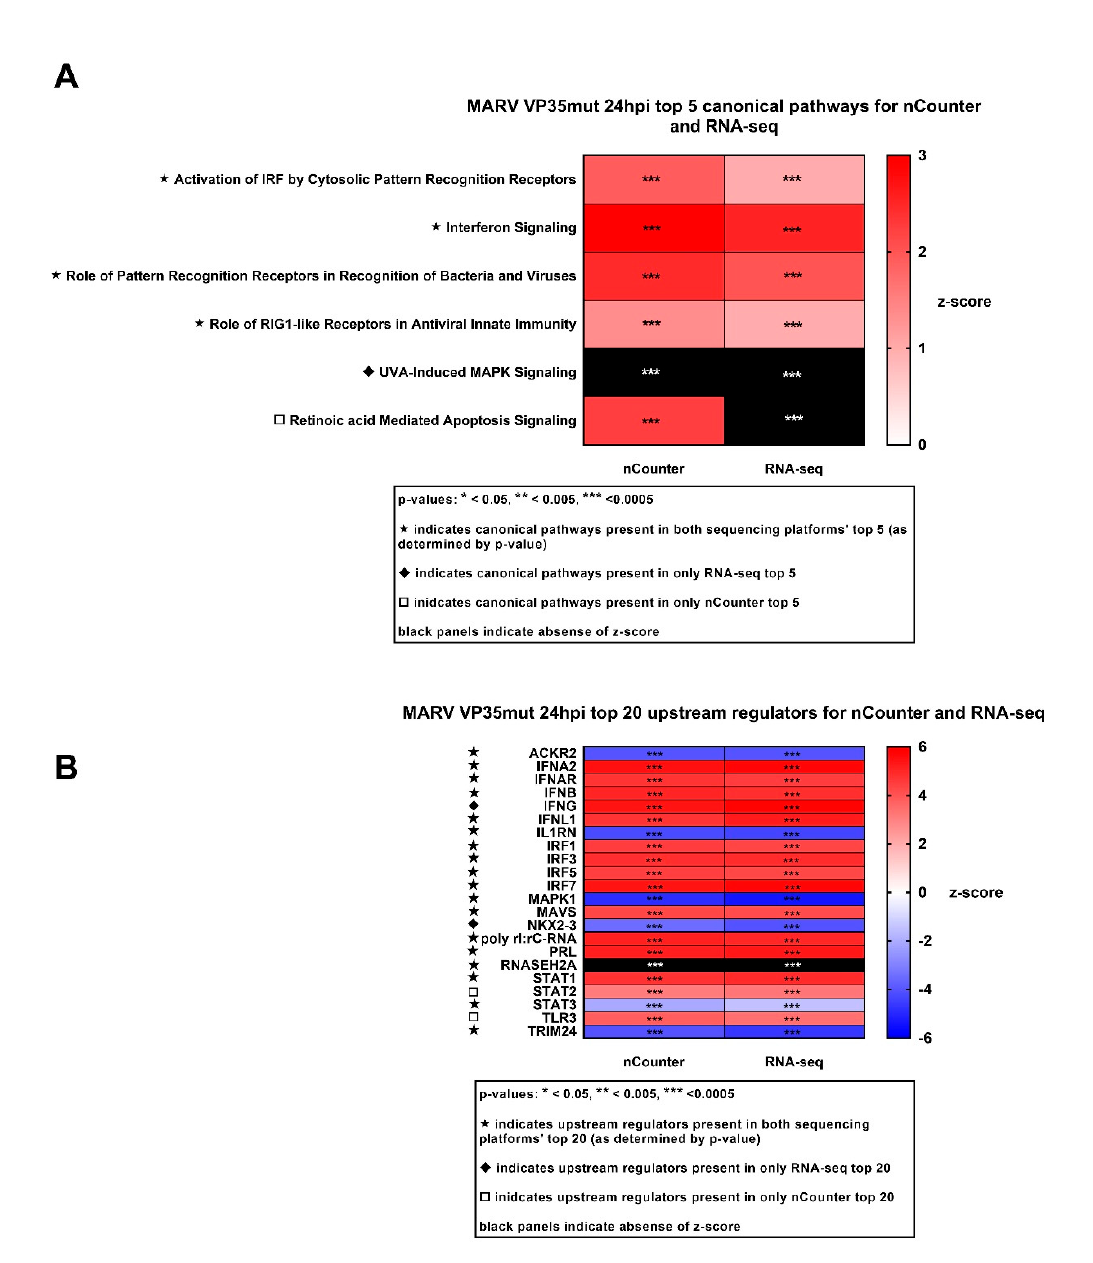
Figure 4. The top five canonical pathway and top 20 upstream regulators comparison between nCounter and RNA-seq for MARVmut. ( A ) The top 5 canonical pathways ranked by p -value. The key indicates which pathways are present in both platforms and which are present in only one. The z-score indicates an activation score calculated by IPA (Ingenuity Pathway Analysis) for each pathway. Positive values indicate that the genes in the dataset are behaving in a way that indicates positive regulation. Negative values indicate that the genes in the dataset are behaving in a way that indicates negative regulation. Black panels indicate canonical pathways that have a significant p -value but lack a z-score. ( B ) The top 20 upstream regulators ranked by p -value. The key indicates which pathways are present in both platforms and which are present in only one. The z-score indicates an activation score calculated by IPA for each pathway. Positive values indicate that the genes in the dataset are behaving in a way that indicates positive regulation. Negative values indicate that the genes in the dataset are behaving in a way that indicates negative regulation.